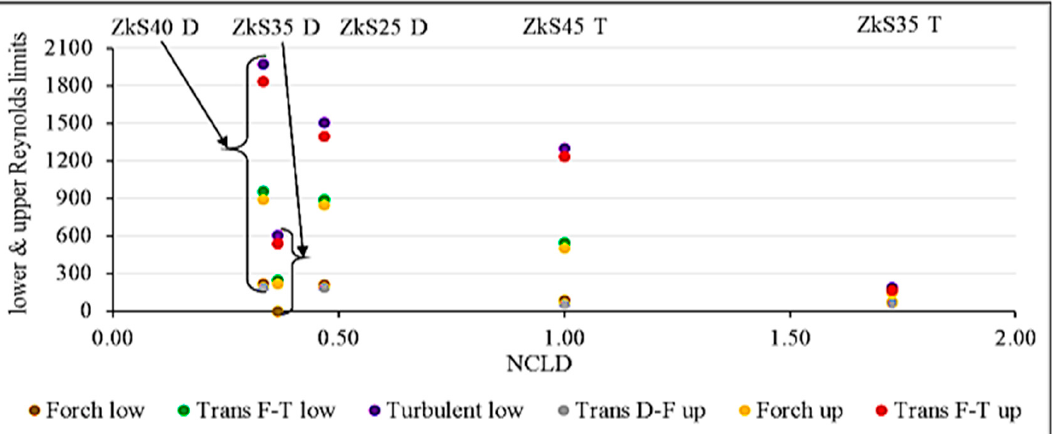
Figure 8. Dimensionless analysis of the effect of sample length on airflow limits using the number of cells per length normalised by the number of cells per sample diameter (NCLD). It is clear that each extension of the regime is deeply influenced by the length of the sample.